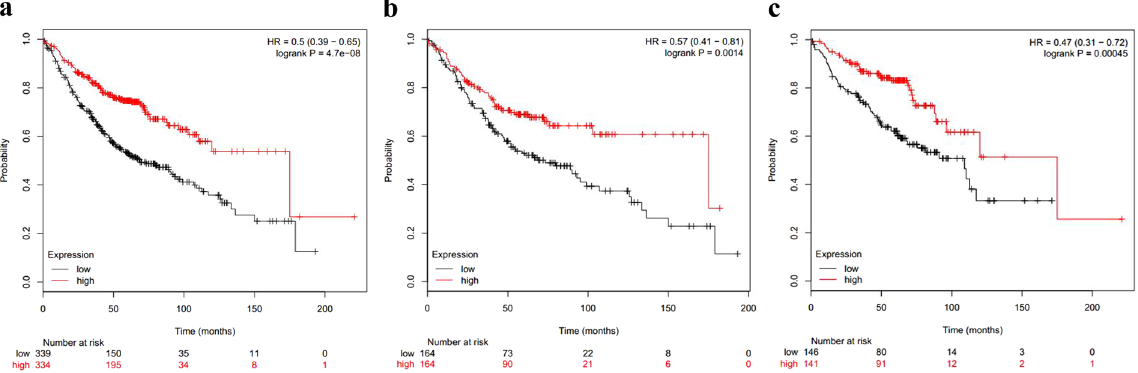
Figure 6. Kaplan–Meier survival curves generated from Kaplan-Meier plotter for TCF21 mRNA expression in patients with lung adenocarcinoma. Overall survival curves for lung adenocarcinoma patients that ignored gender differences ( a ), in male patients ( b ) and in female patients ( c ). HR = hazard ratio.